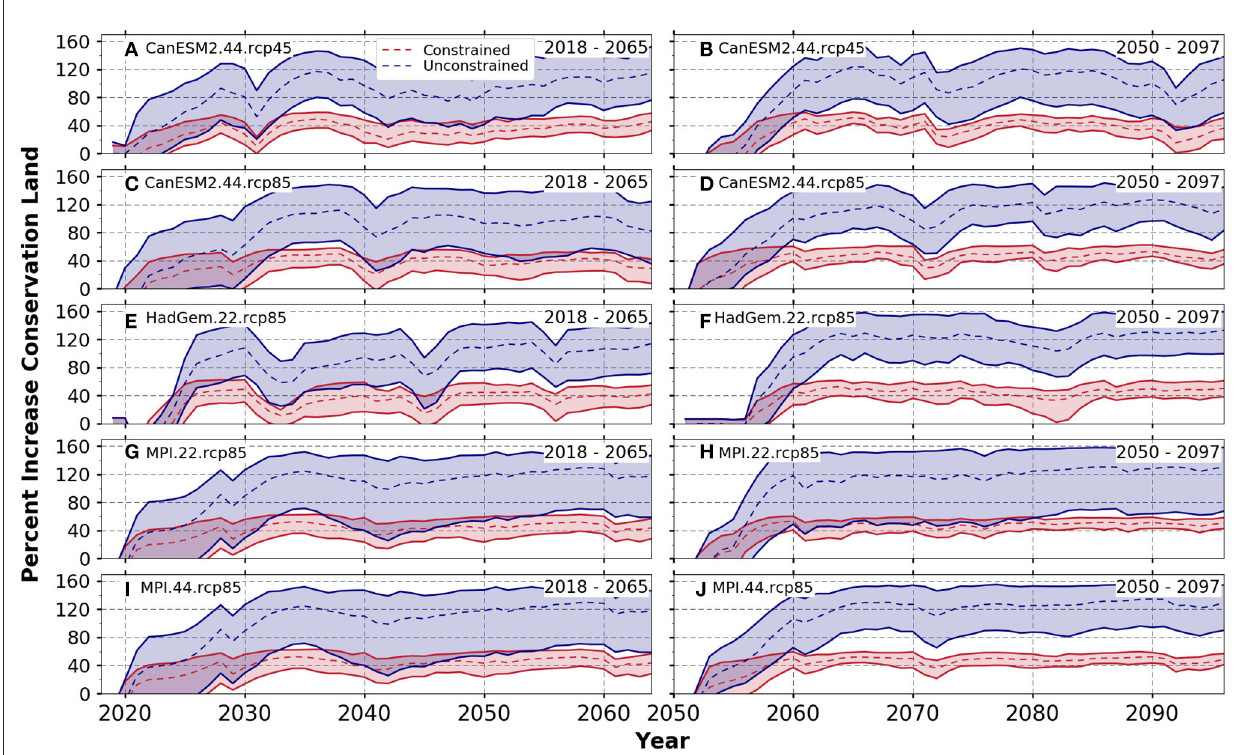
FIGURE5 Means (dashed lines) and ranges (shaded areas) of percent change in conservation land for the constrained (red) and unconstrained (blue) scenarios relative to the constant scenario for 2018–2065 (A, C, E, G, I) and 2050–2097 (B, D, F, H, J)